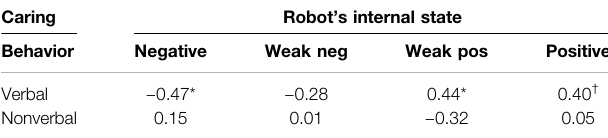
TABLE 2 | Correlation coef fi cients between caring behavior and the robot ’ s state.